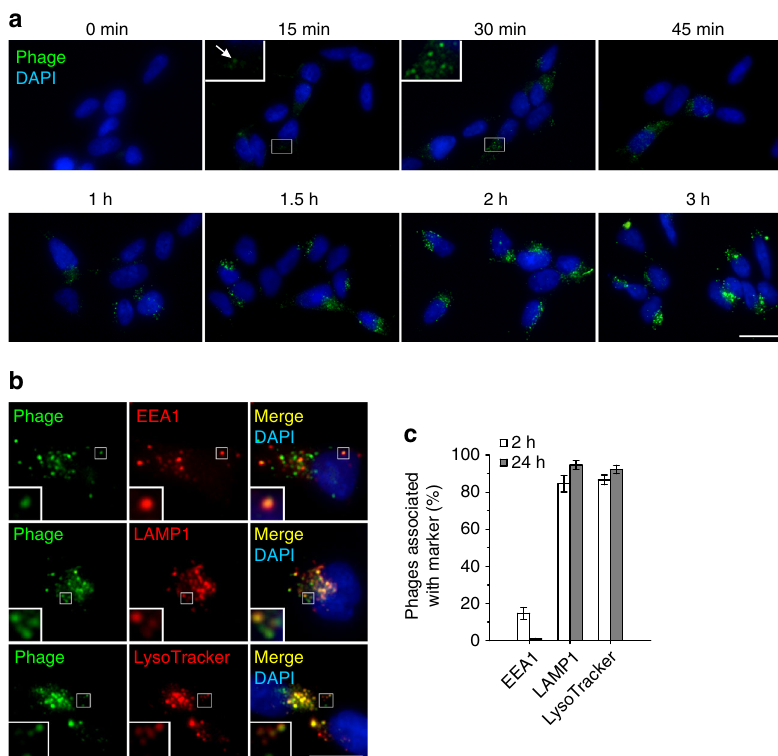
Fig. 4 Progression of phage internalization after removal of surface-bound phages and direction to lysosomes. a Time course of PK1A2 phage internalization into kSK-N-SH cells. Following incubation with FITC-labeled phages (green) for the times indicated at 37 °C, the non-internalized phages were stripped off by polysialic acid competition. An intracellular phage cluster is indicated with an arrow. b Phage clusters in early-endosomal and lysosomal compartments. kSK-N-SH cells were incubated with FITC-labeled phages (green) for 2 h at 37 °C, extracellular phages were removed by polysialic acid competition, and the fi xed cells were immunostained for the early-endosomal marker EEA1 or late endosomal/lysosomal marker LAMP1 (red). The lysosomal stain LysoTracker (red) was added to the medium 30 min before the end of incubation with phage. c Quanti fi cation of phage clusters positive for EEA1, LAMP1 or LysoTracker. Following incubation with FITC-labeled phages for 2 or 24 h at 37 °C, the cells were subjected to immunostaining as in b . The data represent the mean ± s.d. of two independent experiments depicting the results from at least 300 vesicles for each condition. In all experiments nuclei were stained with DAPI (blue). Representative images from two to four biological replicates are shown. The scale bars represent 20 µ m in a , 10 µ m in b , the insets have been enlarged